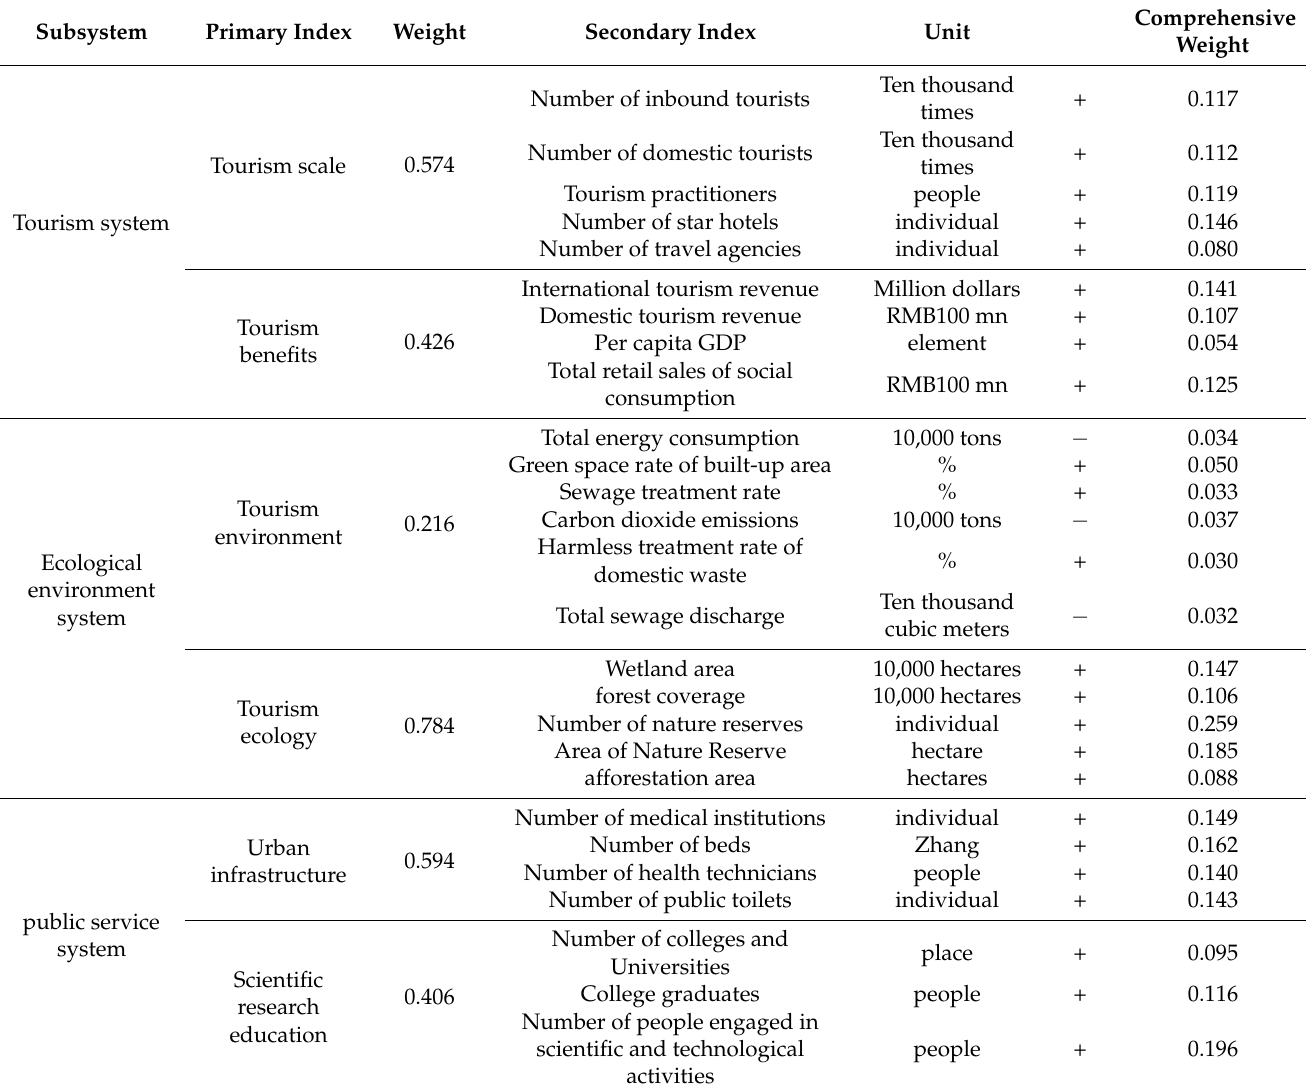
Table 1. The evaluation index system on Tourism, Ecological Environment and Public Service in the Yellow River